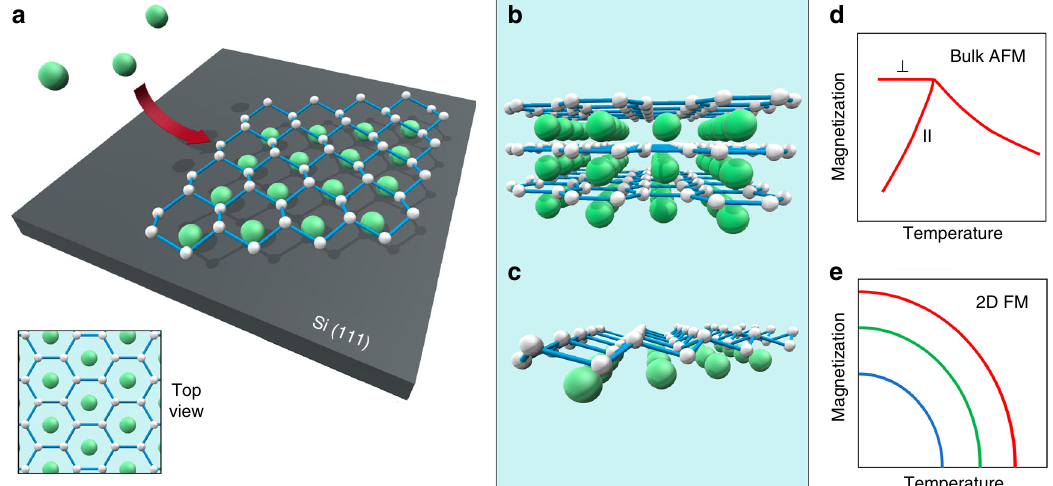
Fig. 1 Schematics of the experiment. a MBE synthesis of MSi 2 silicene materials by directing metal atoms (Gd or Eu) at the Si(111) substrate leading to formation of b a bulk (multilayer) material or c a monolayer. The AFM state of the bulk d transforms into 2D ferromagnetism with its characteristic dependence of the transition temperature on magnetic fi elds